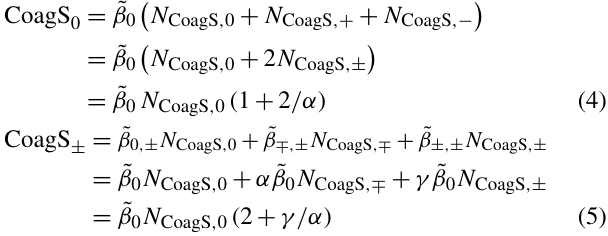
Figure 1. Ion–particle flux attachment coefficient (López-Yglesias and Flagan, 2013a, b) kernel of primary ion with charge i and a particle of size d p . The colors refer to the charge of the smaller par- ticles (modeled as primary ions): red is negative, blue is positive, and black is neutral. The line styles refer to the charge of the bigger particle ( j ): dashed–dotted is ± 5, dotted is ± 1, and continuous is 0. Also shown is the Coulomb diameter, d C , at 111.4nm. Neutraliza- tion coefficients (attachment between particles of opposite charge) tend toward an asymptotic value for d p < d C